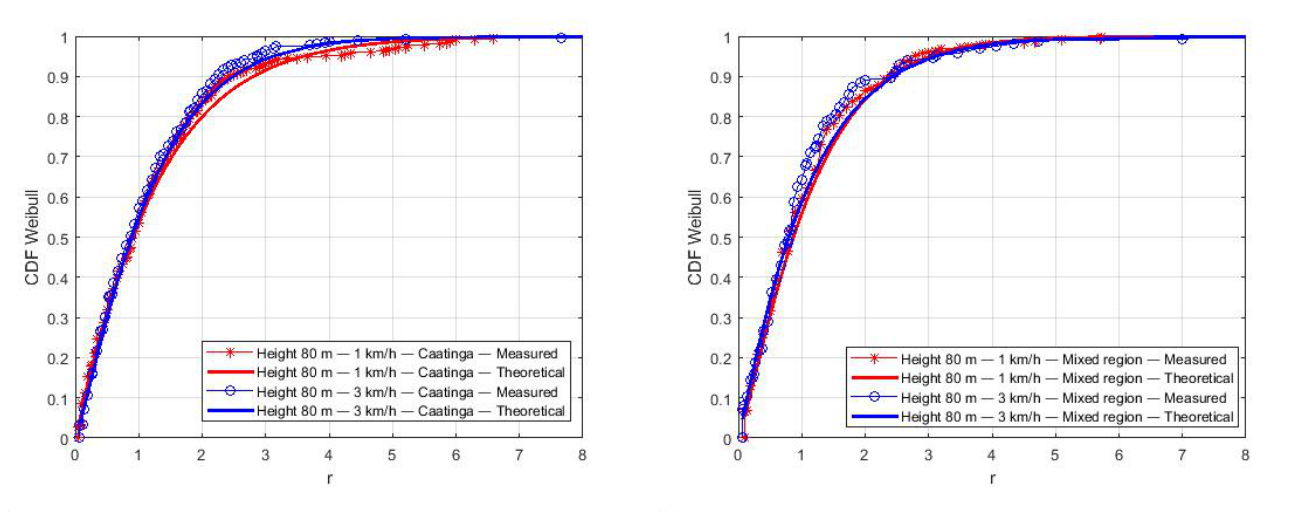
Figure 10. Estimation of CDFs over the lake at the same speed. ( a ) CDFs over the lake at 1 km/h. ( b ) CDFs over the lake at 3 km/h.